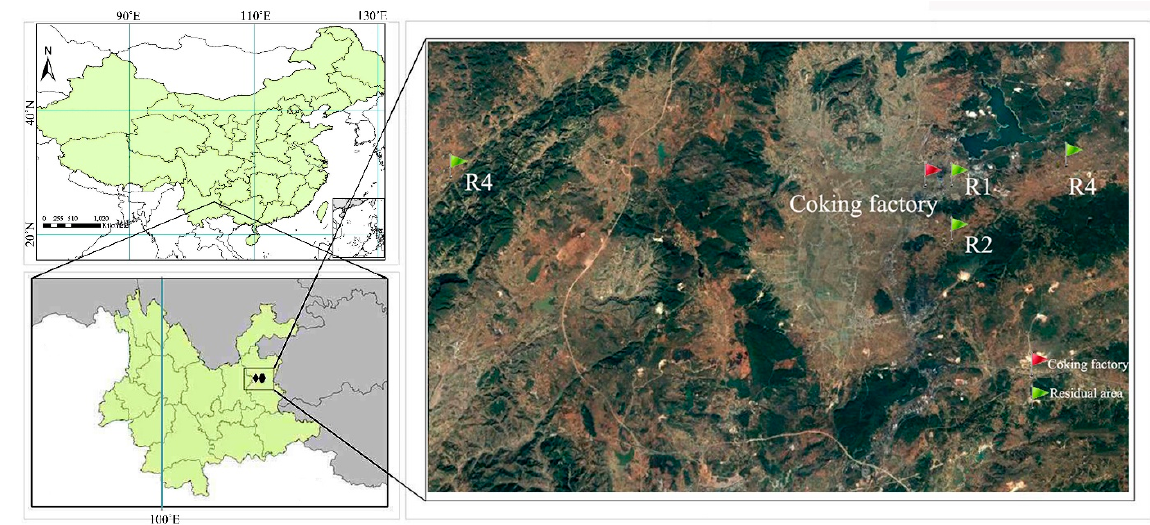
Figure 1. Research area and sampling sites. Atmospheric samples in communities were collected at sites R1, R2, R3 and R4.